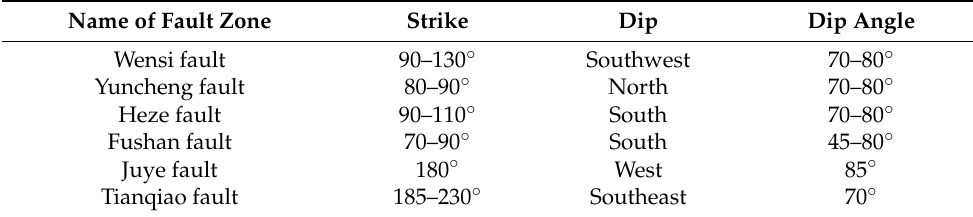
Table 1. Characteristics of the main fault structures in the mining area. Name of Fault Zone Strike Dip Dip Angle Wensi fault 90–130